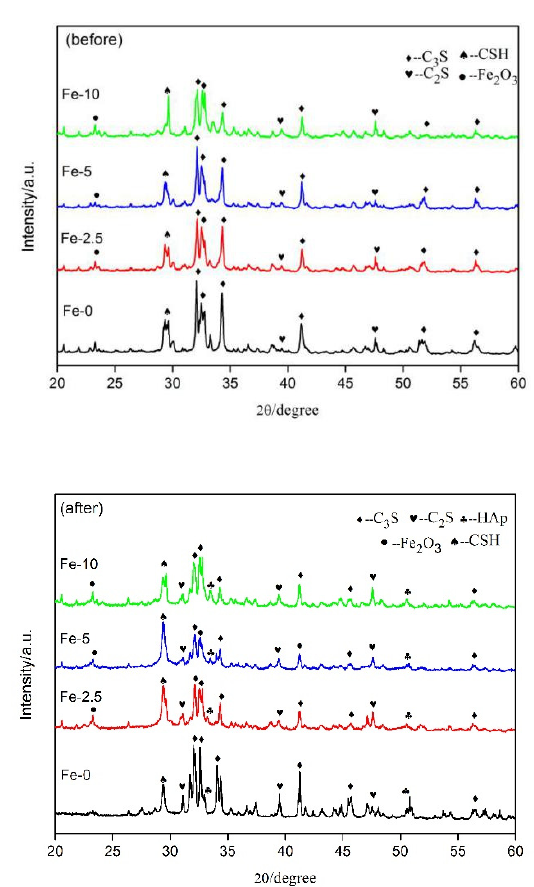
Figure 5. XRD patterns of Fe-0, Fe-2.5, Fe-5 and Fe-10 powders before and after immersing in SBF solution for seven days.